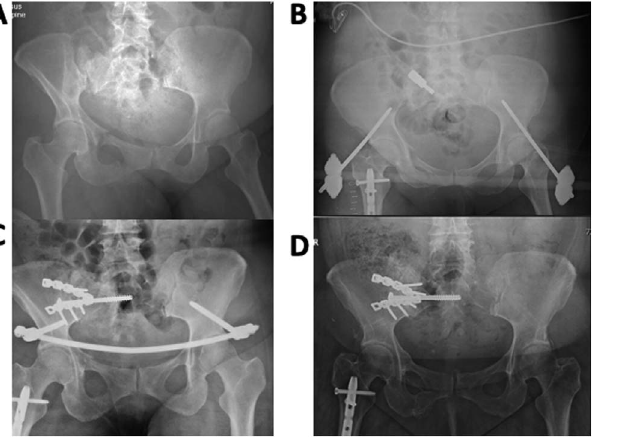
Figure 3. In one case, a supra-acetabular external fi xator was used, and the resulting INFIX got infected despite using different holes for the implants. (a) Preop X-ray, (b) with temporary external fi xator, (c) after de fi nitive fi xation, (d) at last